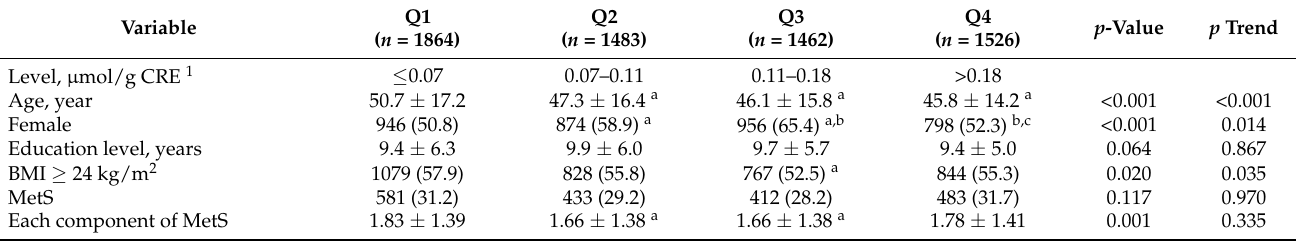
Table 2. Factors associated with the quartiles of urine 1-OHP concentration level ( N = 6335).